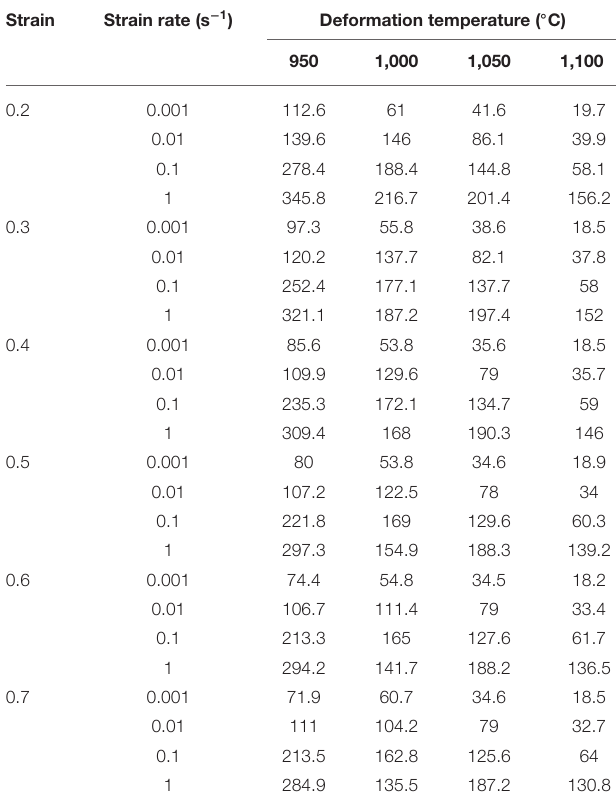
TABLE 1 | The flow stress experimental data (MPa) of the Ti-25.5Al-13.5Nb-2.8Mo-1.8Fe alloys at various deformation conditions.